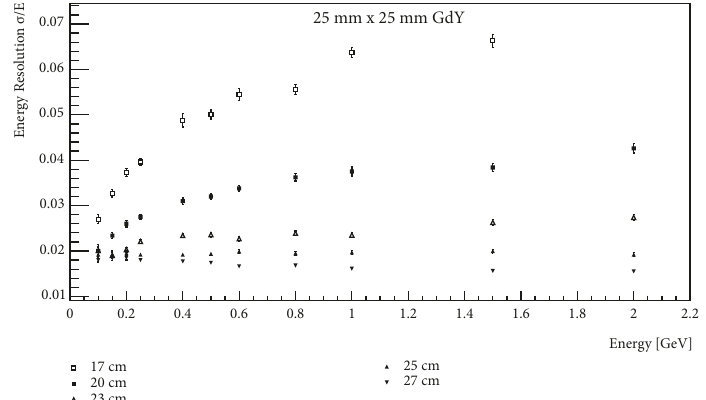
Figure 3: Energy resolutions as a function of beam energy for GdY with 25 mm x 25 mm back face area and five different thicknesses.